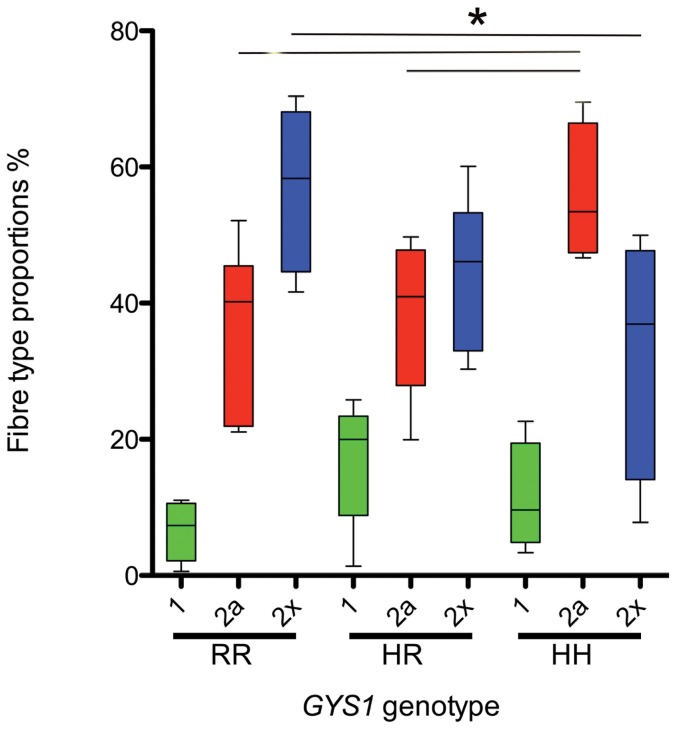
Muscle fibre type distributions.Boxplots illustrating the muscle fibre type composition of horses homozygous (HH) (n = 4), heterozygous (HR) (n = 8) and control horses (RR) (n = 6). * Denotes significant differences between individual groups (p<0.05) following post- hoc analysis.